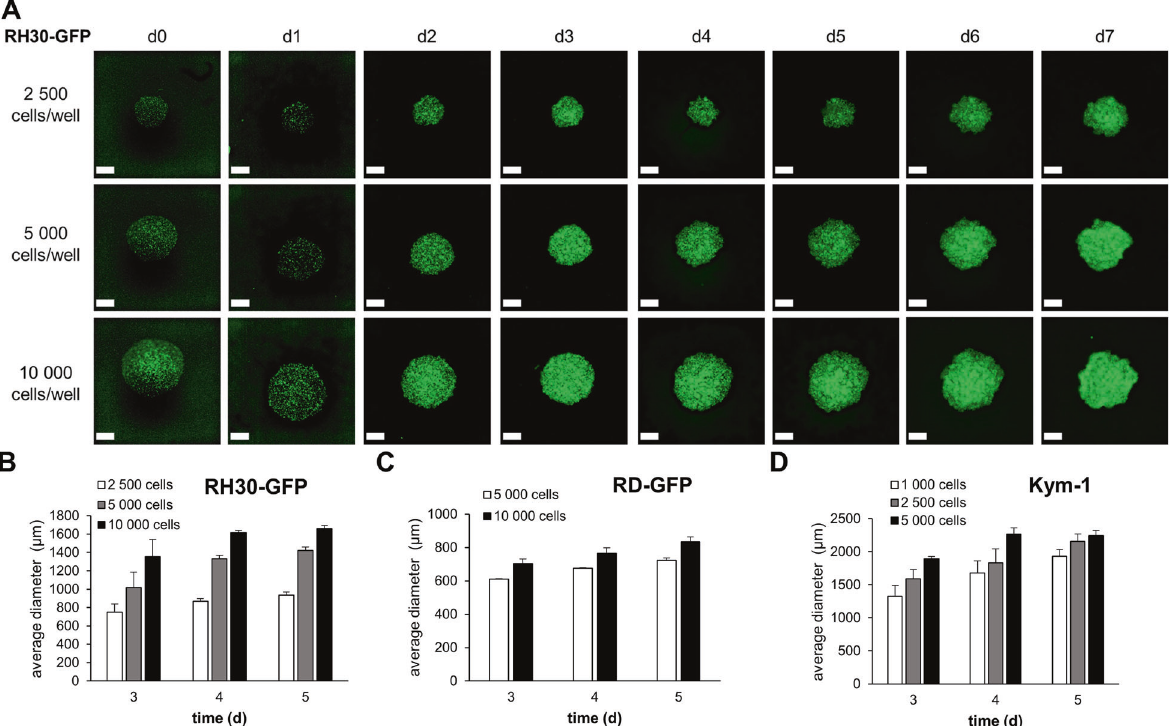
Fig. 1 Spheroid formation in RMS cells. RH30-GFP cells were cultured in 96-well ultra-low attachment plates at different cell densities. To enable spheroid formation, plates were centrifuged at 1 000 g for 10 min directly after seeding. A GFP fl uorescence signal of